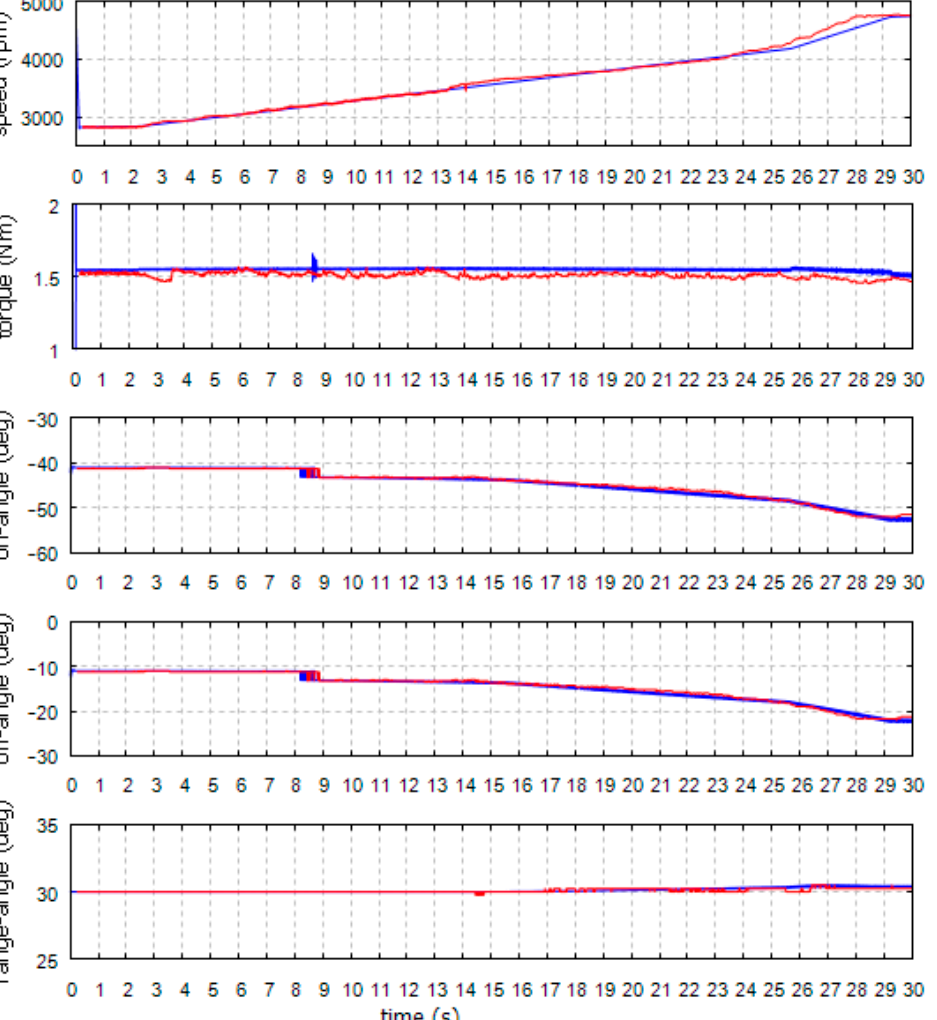
Figure 13. Speed waveforms and corresponding values of commutation angles at constant load torque.